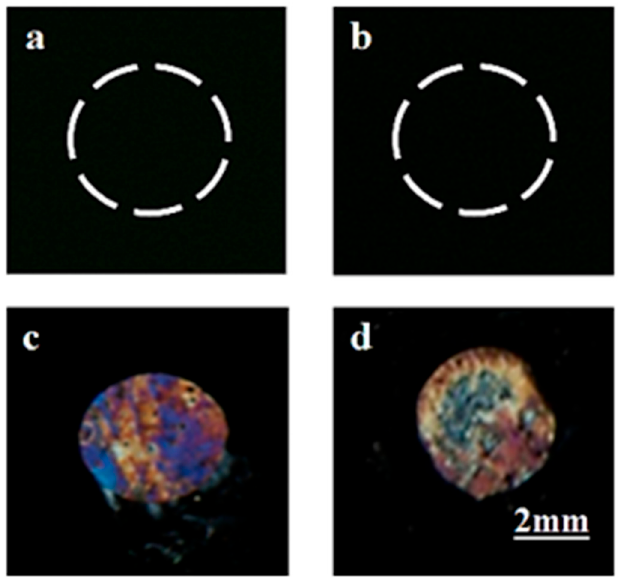
Figure 6. Specificity of the AuNPs–PDMS stamp with immobilized B40t77 aptamer probe after incubation with a solution of the mixture of two proteins (FITC-IgG + gp-120) is demonstrated by fluorescence images with no signals show no binding and transfer of FITC-IgG, ( a ) when 8 µ g/mL quantity of gp-120 and FITC-IgG were mixed, and ( b ) when 8 µ g/mL of gp-120 and 16 µ g/mL of FITC-IgG were mixed. Bright optical images of LCs showing selective binding and transfer of gp-120 onto DMOAP-coated glass slide, ( c ) when 8 µ g/mL quantity of gp-120 and FITC-IgG were mixed, and ( d ) when 8 µ g/mL of gp-120 and 16 µ g/mL of FITC-IgG were mixed.